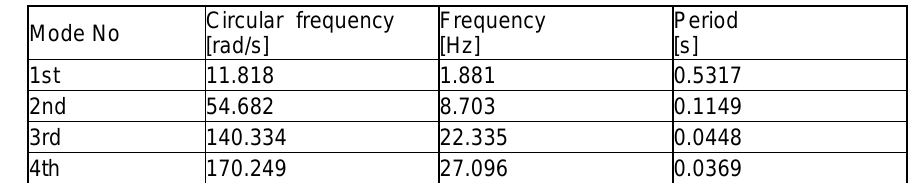
Table 5 – Frequencies of the model with 7 finite